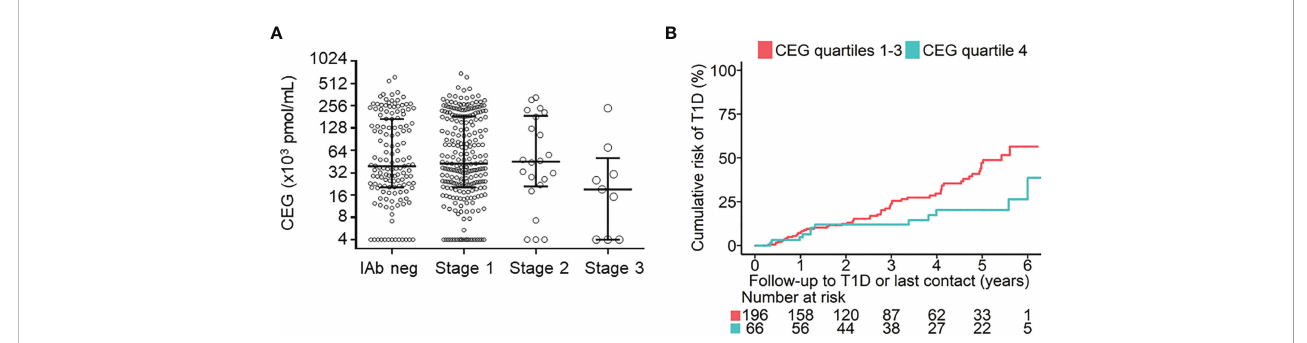
FIGURE 1 Relationship between CEG levels and islet autoantibody status, stage of pre-symptomatic type 1 diabetes (T1D), and risk of progression to clinical T1D (stage 3). (A) shows CEG levels for 141 islet autoantibody-negative children (IAb neg), 240 children with stage 1 T1D, 22 children with stage 2 T1D, and 9 children with stage 3 T1D. Median (IQR) values are shown for each group. (B) shows the cumulative risks of developing stage 3 T1D in children with stage 1 or 2 T1D for children with CEG levels in the highest quartile (Q4) of measurements (blue line) compared with children with lower CEG levels (Q1-Q3; red line) (P=0.001; log-rank test). Follow-up begins at initial staging by OGTTs. The number of children at risk is shown below each time